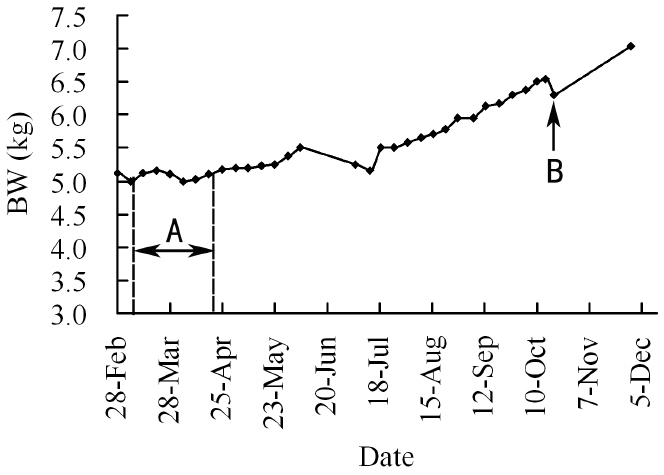
Figure 2. Body weight change of the female pangolin MP8 during the gestation period (from 8 Mar to 19 Oct 2011). A duration for MP8 housing with MP1 together B date of MP8 giving